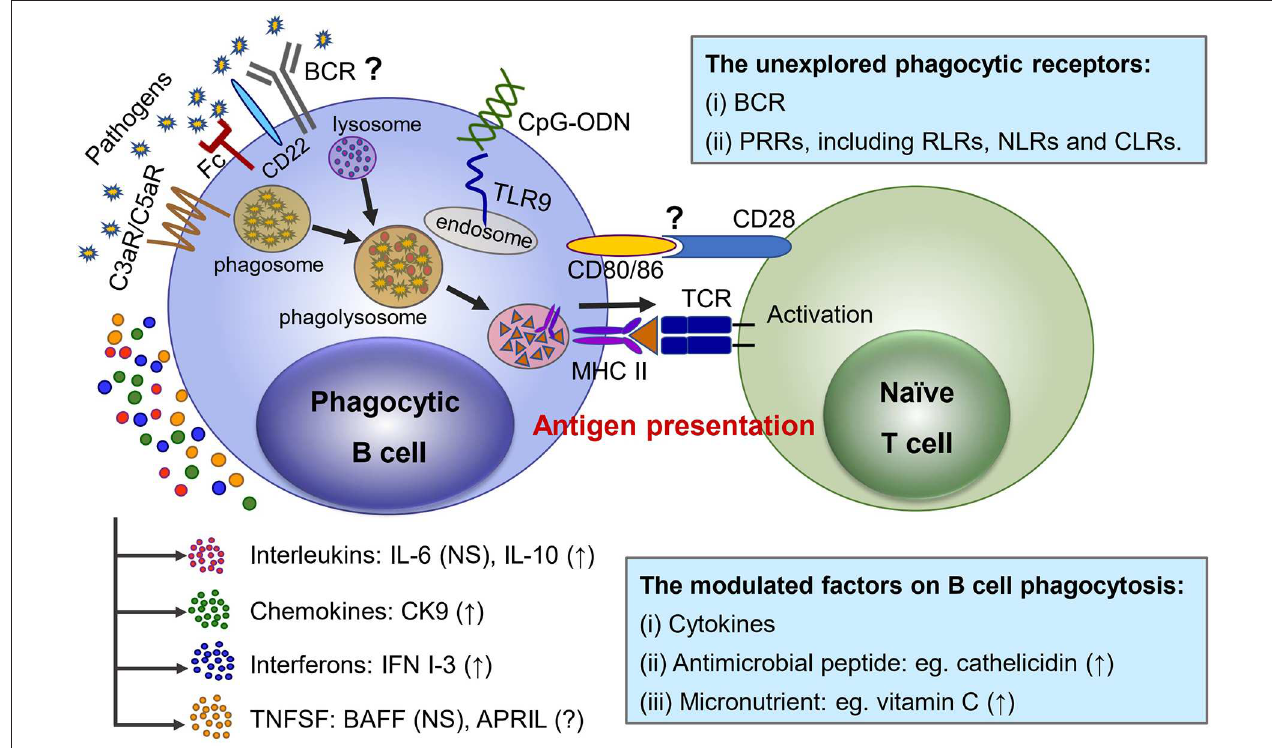
FIGURE 1 | Phagocytic receptors and modulating factors functioning in the phagocytosis as well as the antigen-presenting effect to naïve T cells in teleost phagocytic B cells. (1) Fc, C3a, and C5a receptors presenting at the surface of teleost B cells are involved in phagocytosis. CD22 plays regulatory roles in the micropinocytosis-dependent pathway to internalize large particles by turbot and Japanese flounder IgM + B cells, but the contribution of BCR remains to be further studied. The PRRs recognize a wide variety of PAMPs to initiate phagocytosis, and TLR9 ligation is mediated by CpG ODN, resulting in the phagocytic capacities of splenic IgM + B cells being up-regulated. Other PRRs, including RLRs, NLRs, and CLRs, remain to be explored. (2) Some cytokines are involved in the phagocytosis regulation of teleost B cells; specifically, IL-10, CK9, and IFN I-3 up-regulate phagocytosis, while IL-6 and BAFF have no significant effect. Other factors, such as antimicrobial peptide (cathelicidin) or micronutrients (vitamin C), have been proved to have an up-regulation function on teleost B-cell phagocytosis. (3) Pathogens (such as bacteria and viruses) are recognized by teleost B cells and engulfed into a vesicle as phagosome, with subsequent formation of maturated phagolysosome with a lysosome. The phagocytic B cells digest the internalized contents into component parts and proceed to antigen presentation with MHC II, which activates naïve T cells. However, no direct evidence has yet clarified how CD80/86 interact with CD28 in naïve T cells when B cells proceed to antigen presentation. “?” means as yet unknown; “NS” indicates no significant effect; “ ↑ ” means